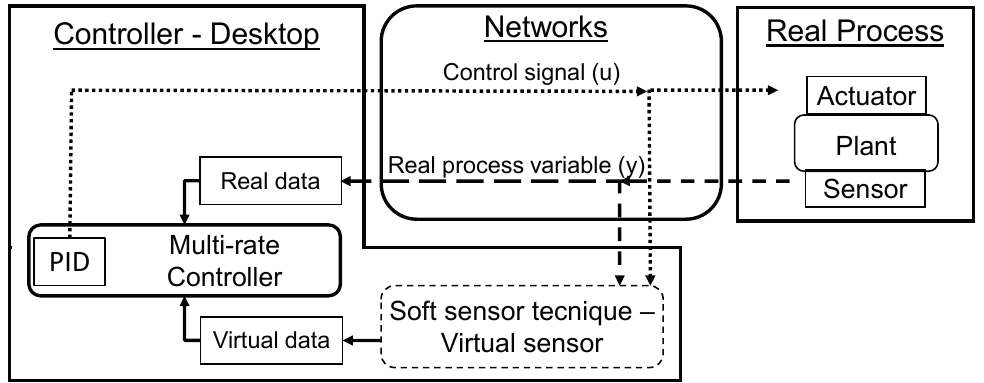
Figure 2. Schematic of the soft sensor strategy with multi-rate control for